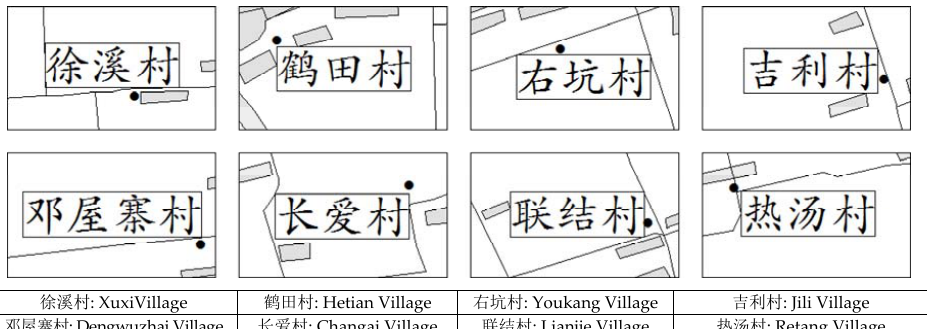
Figure 15. Representative labeling cases for the RoadResident instance. And the Chinese words are the geographic names to be labeled with no conflict.